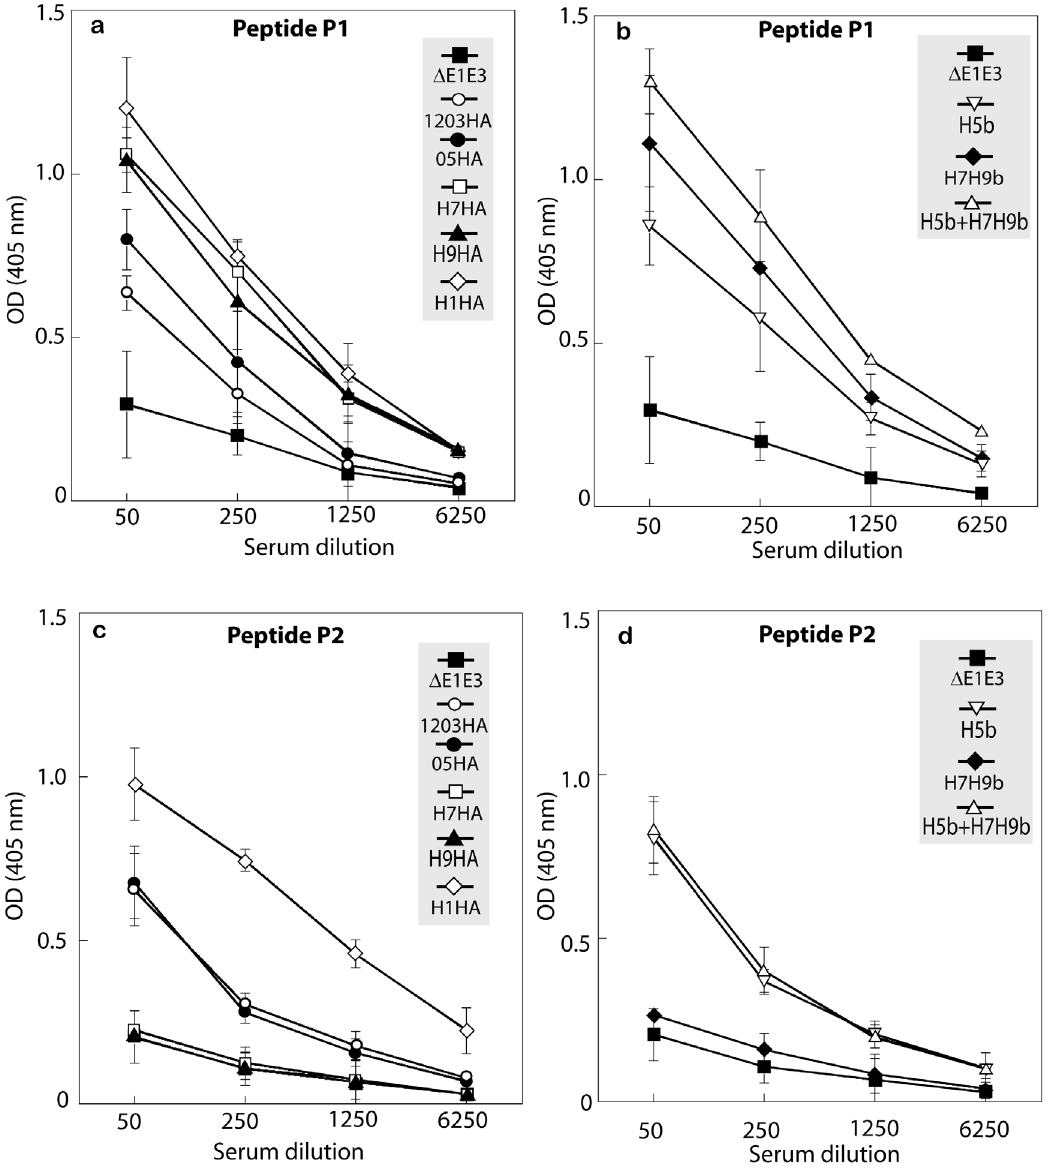
Figure 4. Induction of antibodies against the HA stalk region following immunization with AdV vector-based vaccines. Mice (7 animals/group) were immunized with 1203HA, 05HA, H5b, H7HA, H9HA, H7H9b, H1HA, H5b + H7H9b, or D E1E3 twice at four-week intervals. Four weeks post-booster inoculation, serum samples were obtained for determining ELISA antibody titers against peptides P1 (a and b) and P2 (c and d) as described under Materials and Methods. The data represent mean titers 6 standard deviation (SD) from 7 animals per group. 1203HA, HAd-1203HA; 05HA, HAd-05HA; H5b, HAd-1203HA-05HA; H7HA, HAd-H7HA; H9HA, HAd-H9HA; H7H9b, HAd-H7HA-H9HA; H1HA, HAd-H1HA; H5b + H7H9b; HAd- 1203HA-05HA + HAd-H7HA-H9HA; D E1E3, HAd- D E1E3. of P1 and/or P2 peptide-specific antibodies compared to the groups receiving a monovalent vaccine and the highest levels were observed with the multivalent vaccine [H5b + H7H9b] (Fig. 4c and 4d).